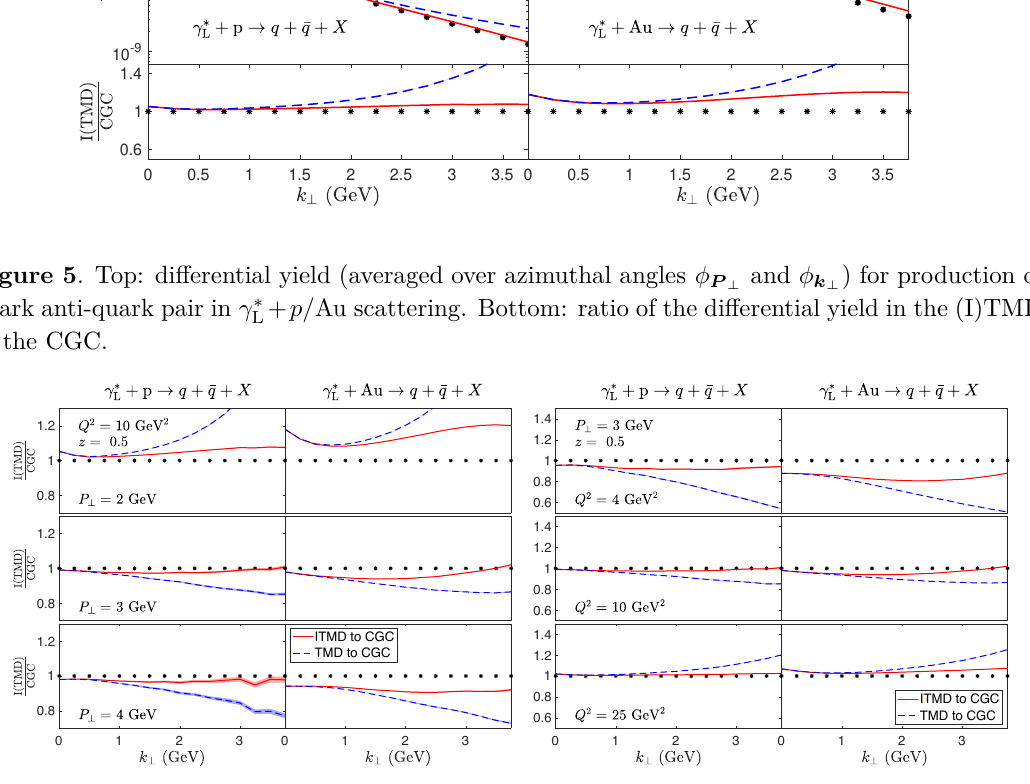
Figure 6 . Ratio of the averaged angle differential yield (I)TMD to CGC at different values of Q (left), and at different values of P ⊥